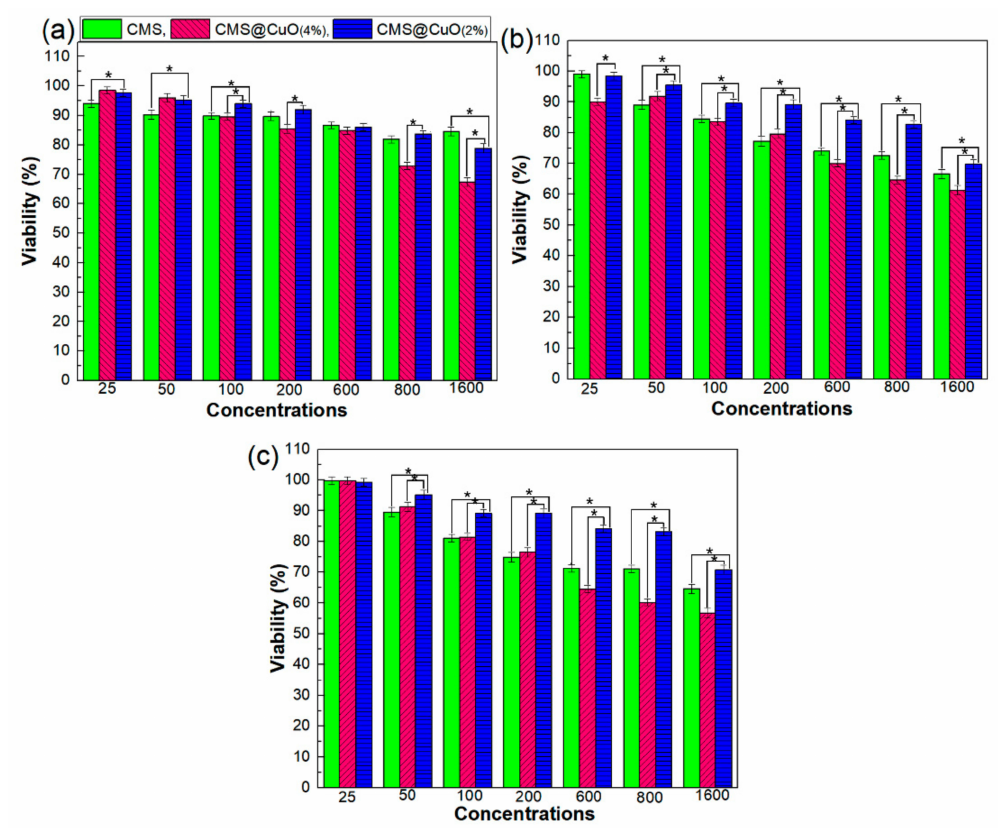
Figure 6. Cell viability (%) of human fibroblasts after exposure to CMS, CMS@2%CuO, and CMS@4%CuO specimens in the culture medium for 24 h ( a ), 48 h ( b ), and 72 h ( c ). Asterisks (*) indicate a significant difference ( p < 0.05) between viability percent of treated cells with CMS@2%CuO as most efficient hydrogel and ones treated with CMS and CMS@4%CuO in one-way ANOVA test at a confidence interval of